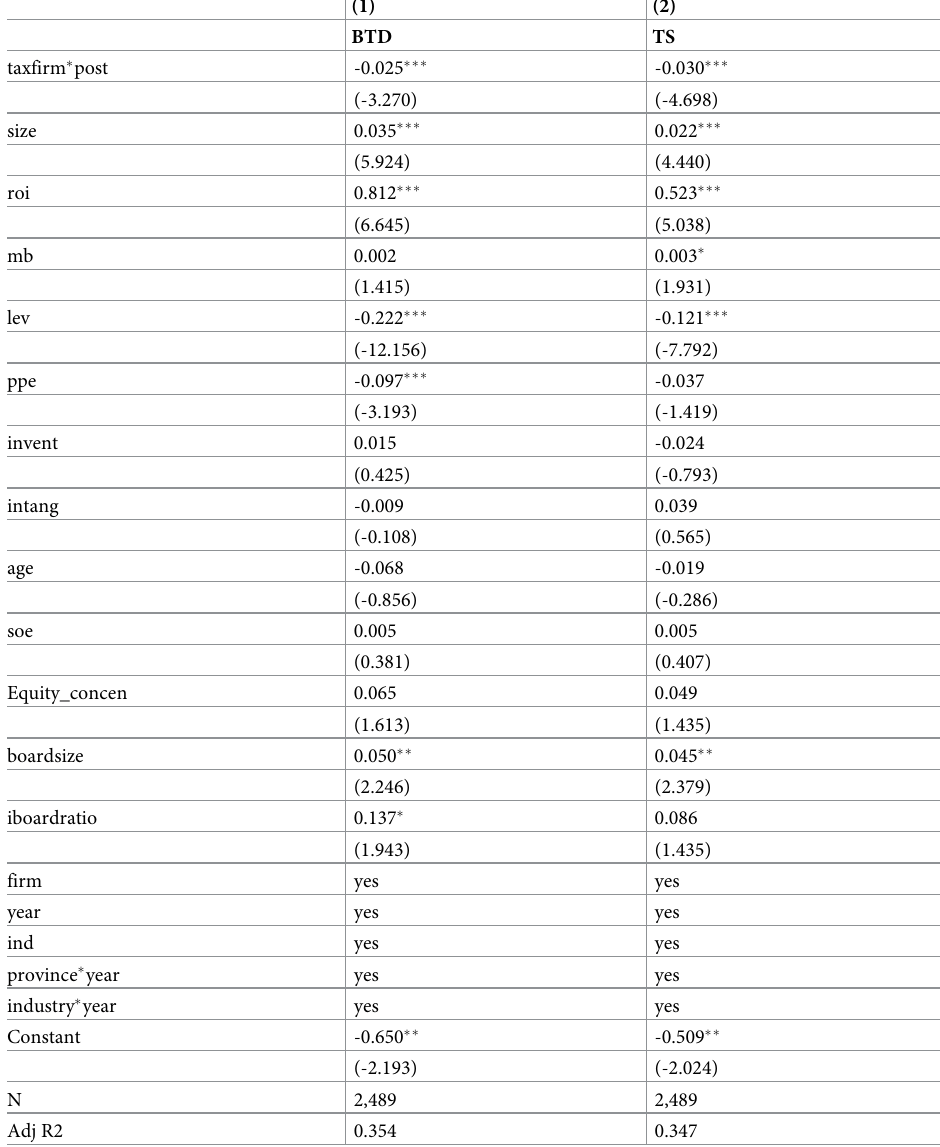
Table 10. Controls the impact of tax policy